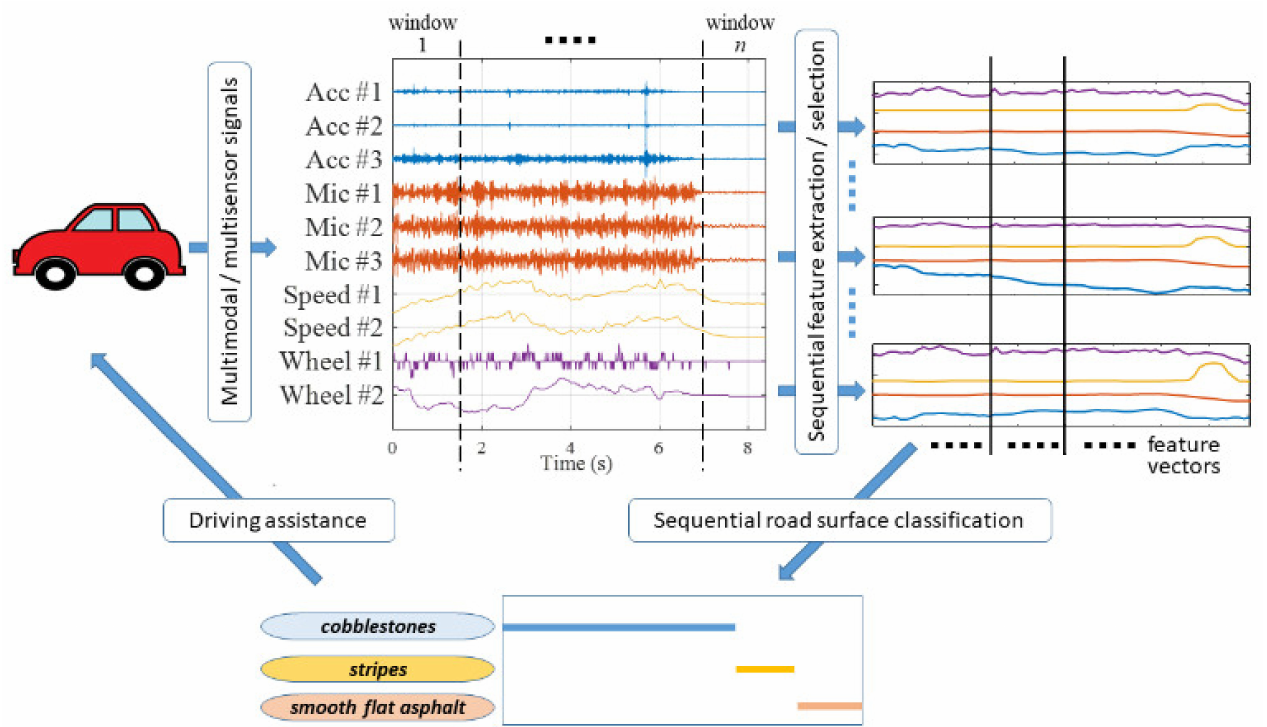
Figure 1. Multisensor road surface classification